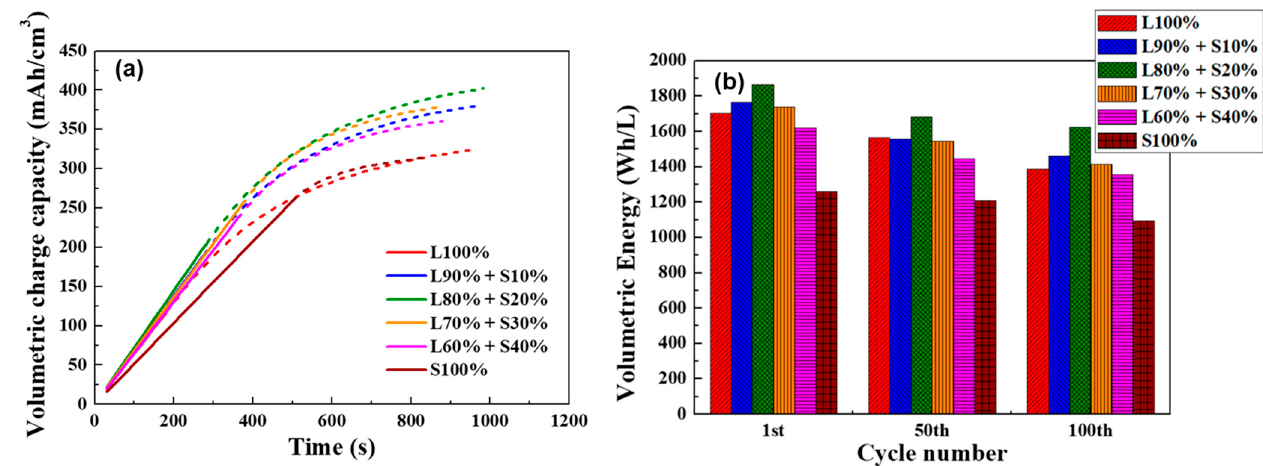
Figure 8. ( a ) Volumetric charge capacity vs. time under the current density of 5 C, and the histogram of ( b ) volumetric energy density for uni- and bimodal NCM cathodes at 1st, 50th, and 100th cycle under CC mode.